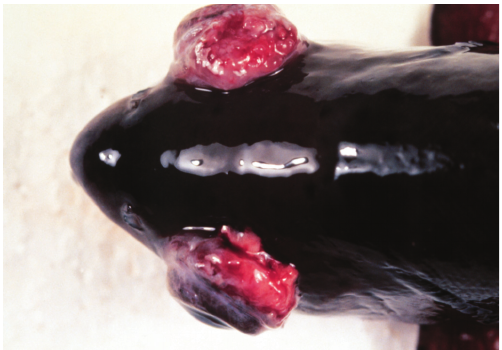
Figure 1: Cryptobia salmositica with red cell from an experimentally infected rainbow trout (reproduced from Woo [5]).